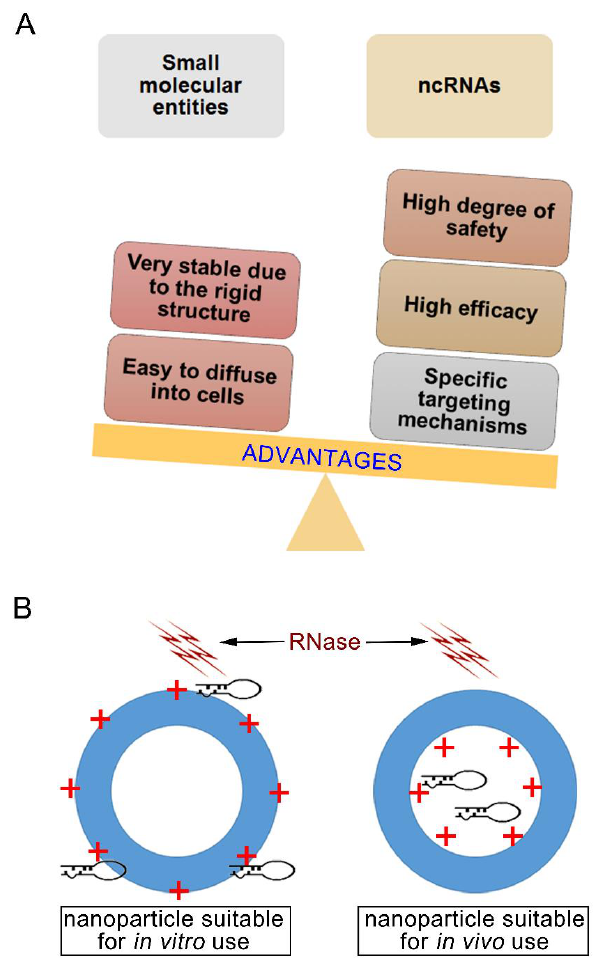
Figure 1. The advantages of ncRNAs against metastatic breast cancer (MBC) and the general structures for the non-viral delivery vehicles. ( A ) The advantages comparison between small molecular entities and ncRNAs. ( B ) The nanostructure difference between in vitro and in vivo applied nanoparticles. Aiming to prevent the degradation by RNase in vivo, ncRNAs must be loaded into the core of nanoparticles. Loading into the core of the nanoparticle will allow the ncRNA to be successfully applied in clinical settings.